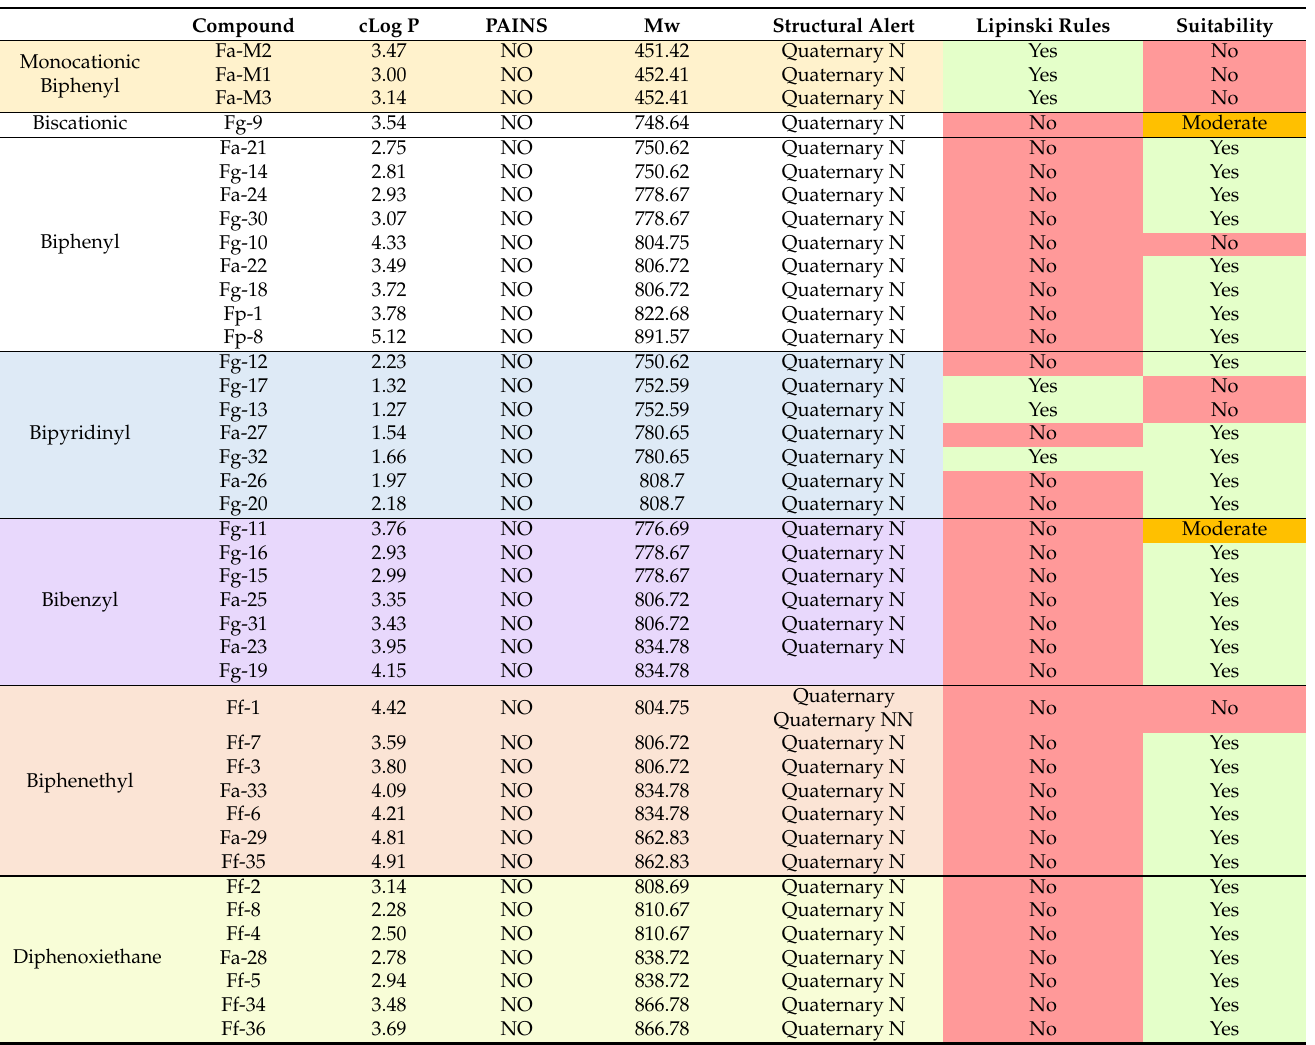
Figure 10. Compound Ff-35 induces apoptosis in A549 ( A ), Hela ( B ), and MDA-MB-231 cells ( C ). Cells were treated with Ff-35 for 72 h at the concentrations of 1 and 5 µM. The cells were then harvested and labeled with annexin-V-FITC and PI and analyzed by flow cytometry. Data are represented as mean ± SEM of three independent experiments. ** p < 0.01, *** p < 0.001; **** p < 0.0001 vs. DMSO. Table 5. In silico predicted physicochemical, drug-likeness, and medicinal chemistry adequacy features for all final